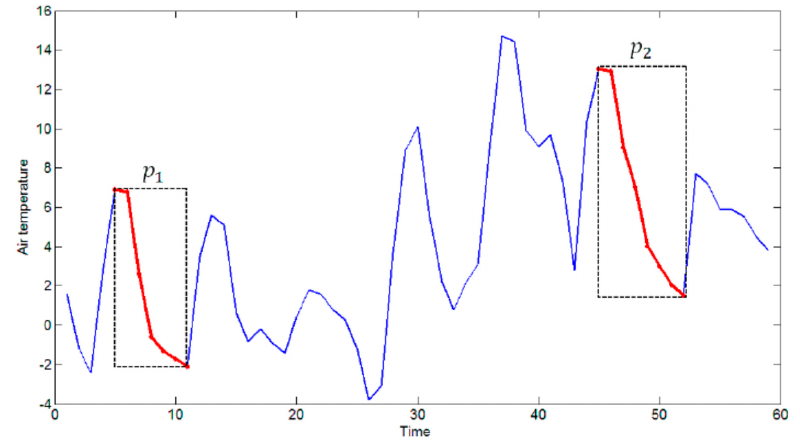
Figure 4. MBR of patterns.